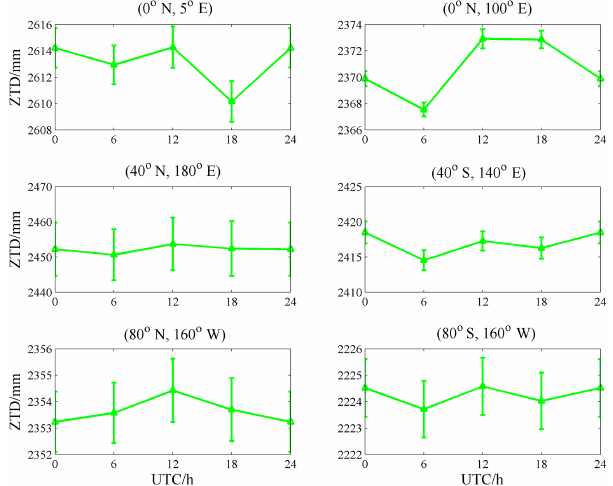
Figure 1. The GZTD model estimates (blue circles) and corre- sponding GGOS grid values (green triangles) at the first DOY of 2010.